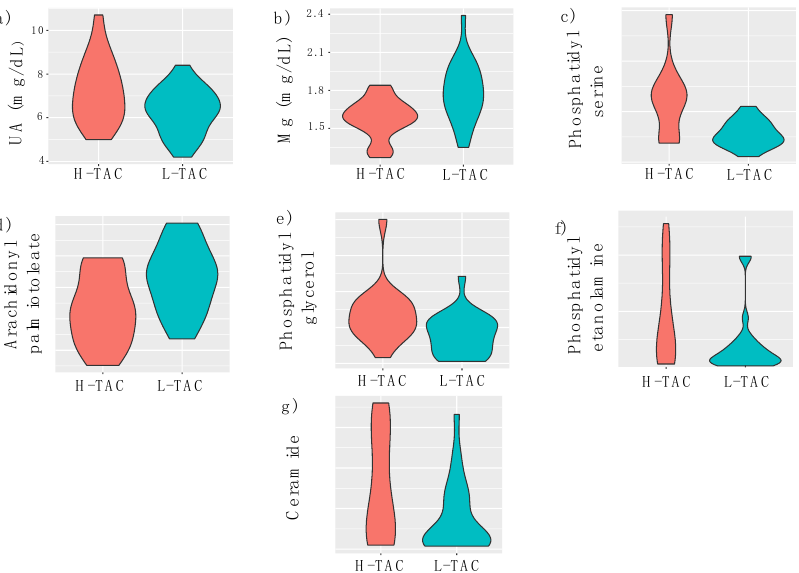
Figure 2. Violin plots of UA-uric acid ( a ), Mg 2+ -magnesium ( b ), phosphatidyl serine (44:8) ( c ), arachidyl palmitoleate (C36:1) ( d ), phosphatidyl glycerol (36:6) ( e ), phosphatidyl ethanolamine (36:4) ( f ), and ceramide (t18:0/22:0(2OH)) ( g ), for the high-tacrolinemia (H-TAC) and low-tacrolinemia (L-TAC) groups.